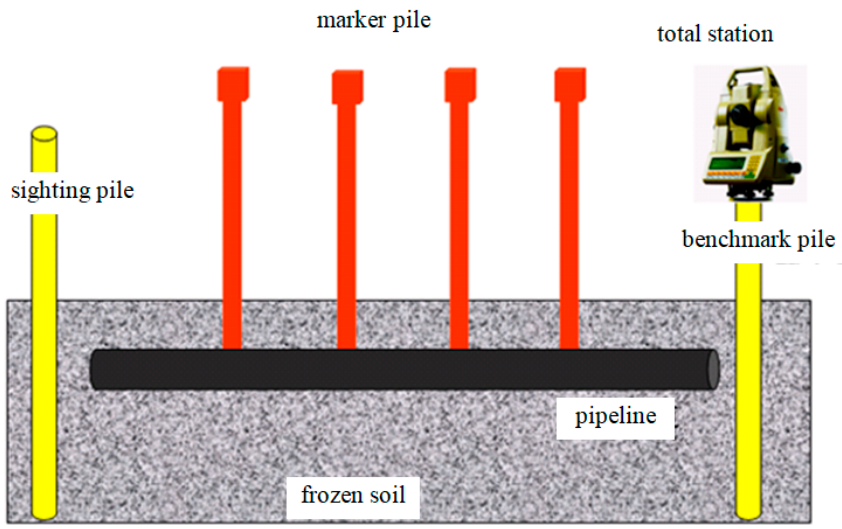
Figure 12. Principles of displacement monitoring method.